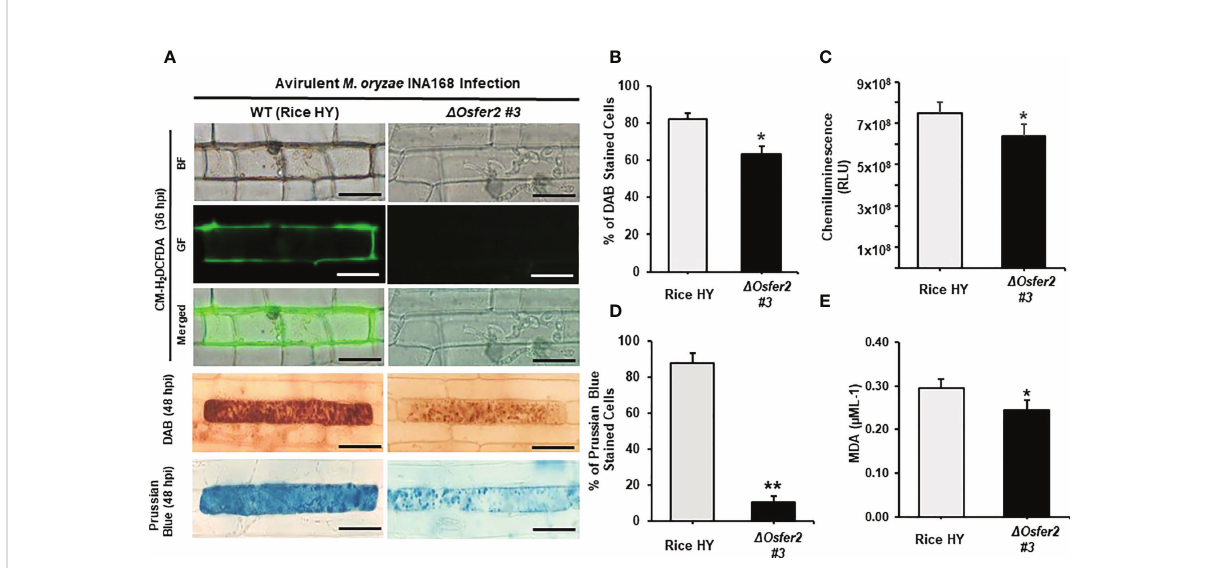
FIGURE 8 OsFER2 knock-out in rice HY inhibits ROS and ferric ion (Fe 3+ ) accumulation and lipid peroxidation in rice leaf sheaths infected with avirulent Magnaporthe oryzae INA168. (A) Microscopic images of epidermal cells of rice leaf sheaths stained with CM-H 2 DCFDA (green fl uorescence), DAB, and Prussian Blue (Fe 3+ , blue color). Images were captured using a fl uorescence microscope (Zeiss equipped with Axioplan 2) with bright fi eld and a combination of excitation (450 ‒ 490 nm) and emission (515 ‒ 565 nm) GF fi lters. Scale bar=20 µm. (B) Quanti fi cation of DAB-stained cells, (C) ROS production, (D) Prussian Blue-stained cells, and (E) lipid (MDA) peroxidation at 48 hpi. Experiments were repeated three times with similar results. The values are means ± SD; n =4 leaf sheaths from different plants. Asterisks indicate statistically signi fi cant differences (Student ’ s t- test, * P< 0.05 and ** P< 0.01). hpi, hour post-inoculation; HR, hypersensitive response; IH, invasive hypahae; BF, bright fi eld; GF, green fl uorescence; RLU, relative luminescent units; MDA,